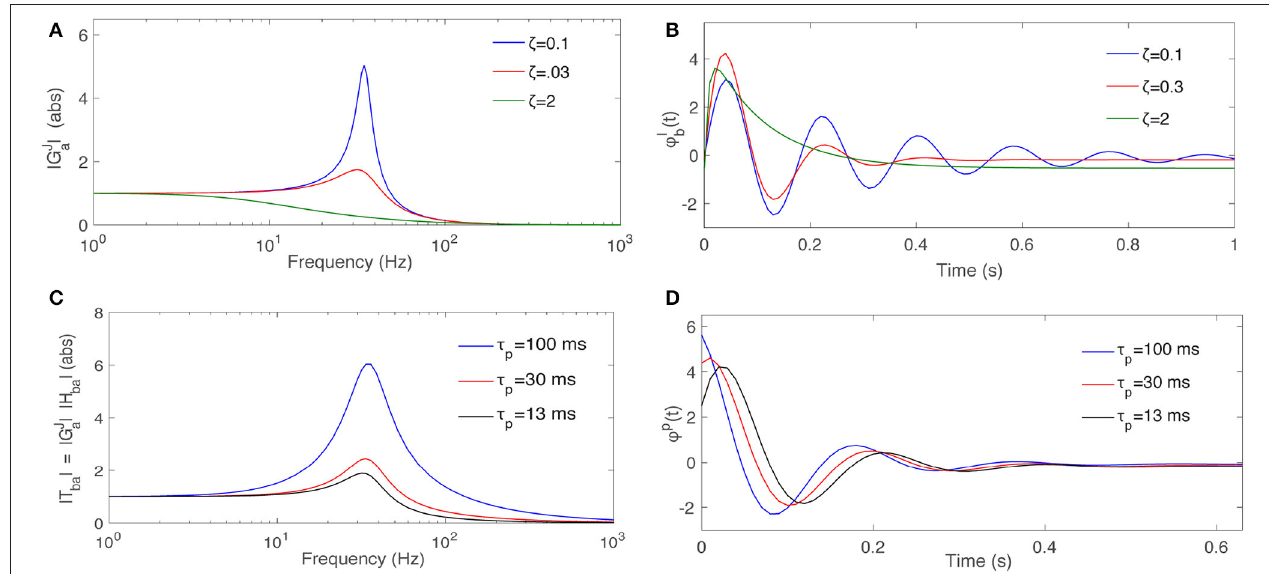
35 s − 1 , K 1, and = = H J ba ( s ) G J a ( s ), for fixed ζ 0.3 and = =